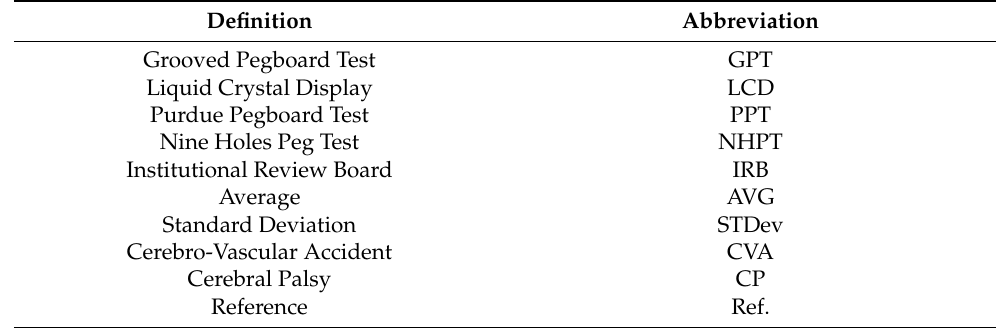
Table A1. Definitions and the abbreviations stand